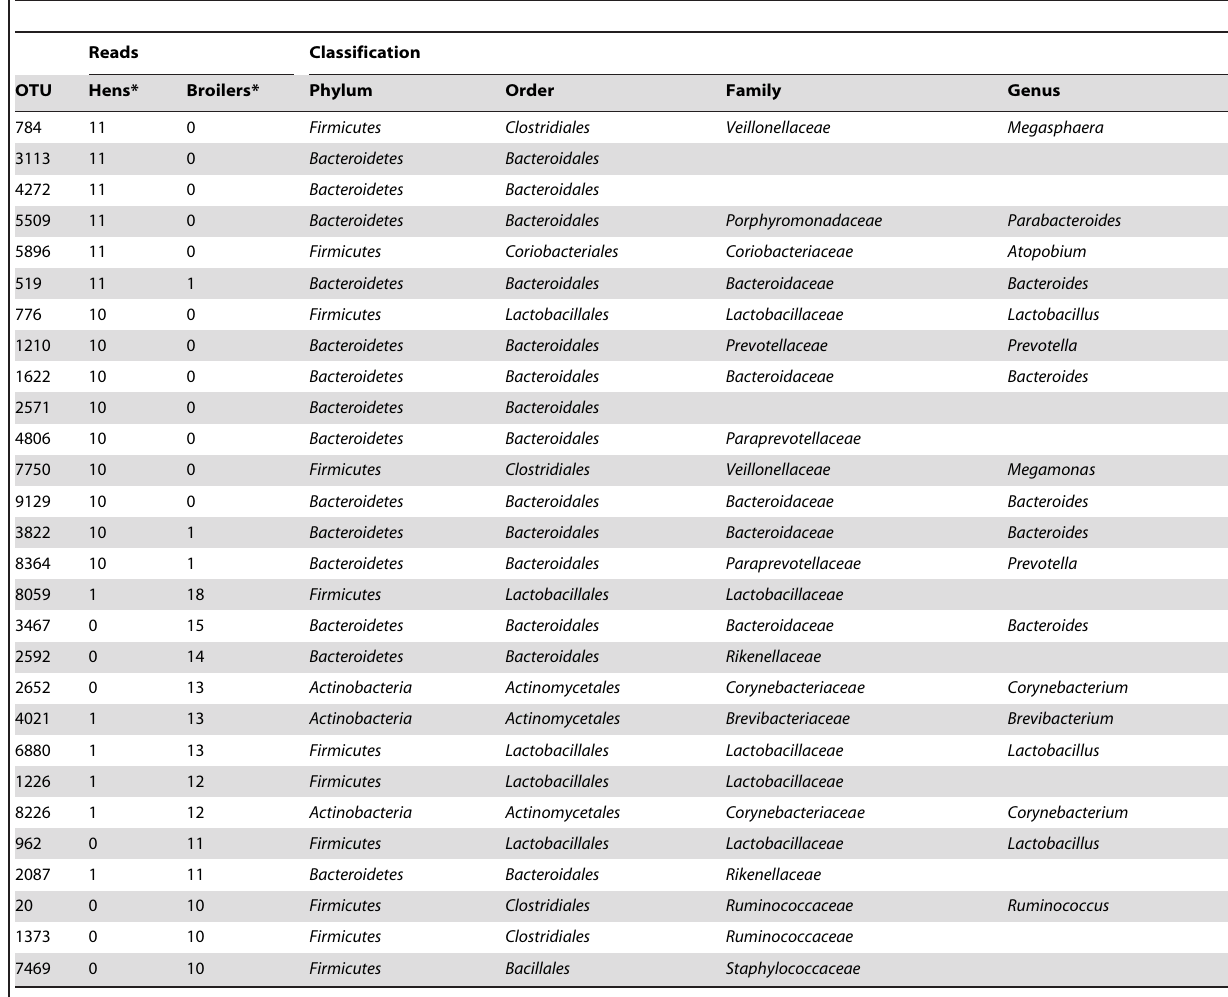
Table 2. List of OTUs present 10 or more times in either hen or broiler fecal microbiota.